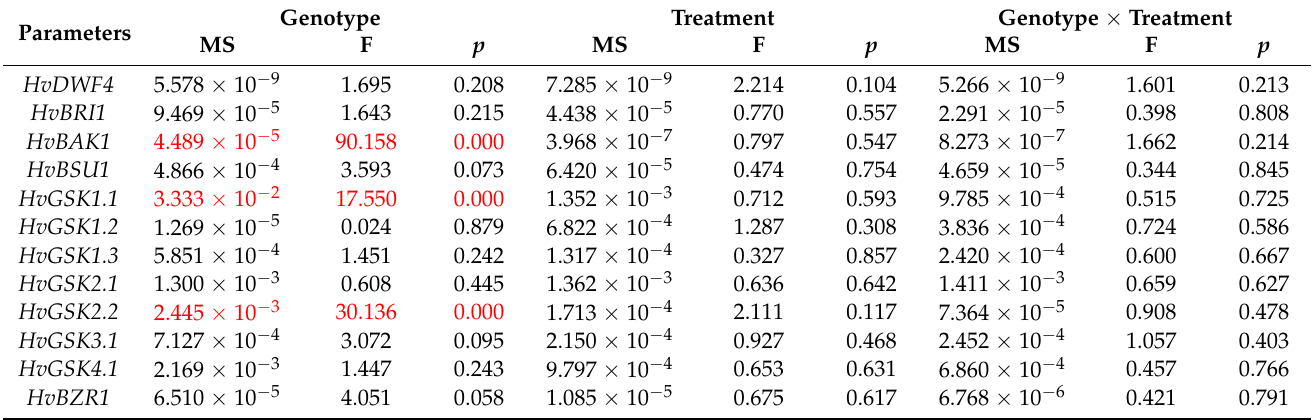
Table 8. Results of two-way ANOVA for two barley genotypes (Golden Promise and Haruna Nijo) grown under salt stress (150 mM sodium chloride) after bikinin treatment (non-treated; treated with 0.11% DMSO; treated with 10 µ M, 50 µ M, and 100 µ M bikinin dissolved in 0.11% DMSO) calculated for genes controlling brassinosteroid (BR) biosynthesis ( HvDWF4 ) and the BR signaling pathway ( HvBRI1 , HvBAK1 , HvBSU1 , HvGSK1.1 , HvGSK1.2 , HvGSK1.3 , HvGSK2.1 , HvGSK2.2 , HvGSK3.1 , HvGSK4.1 , HvBZR1 ) as determined in leaves (3rd and 4th). MS—mean square; F—F-test; p — p